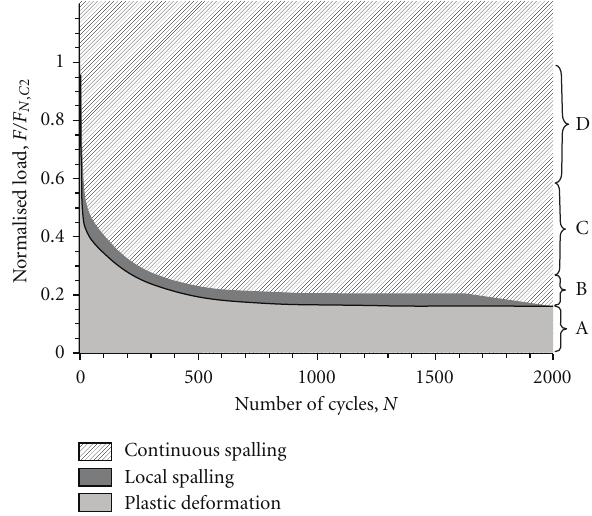
Figure 11: Coating failure map of the Ti 0 . 34 Al 0 . 66 N coating as obtained from the circular multi-pass scratch test. The map illustrates the influence of normalized normal load and number of cycles on dominant failure modes, that is, plastic deformation, cracking and wear, local spalling, and continuous spalling. In the map, four di ff erent regions, A, B, C, and D, are indicated.